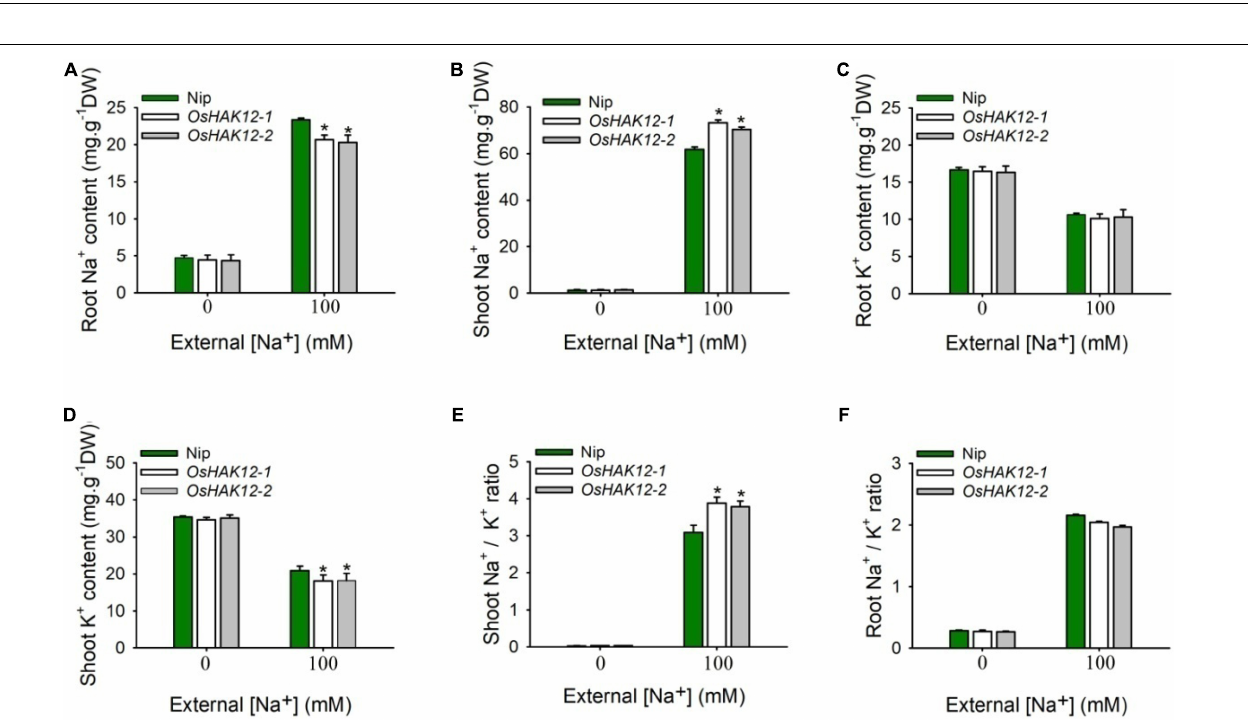
FIGURE 4 | Disruption of OsHAK12 affects Na + and K + ionic accumulation during salt stress. Na + and K + contents of the Nip and Oshak12 mutants ( Oshak12-1 , Oshak12-2 ) were measured by ICP-MS. Growth conditions were as described in Figure 1A . (A) Root Na + content of the Nip and Oshak12 mutants. Significant differences were found between the Nip and Oshak12 mutants ( n = 50 for each data point) (* P < 0.005 by Student’s t -test). (B) Shoot Na + content of the Nip and Oshak12 mutants. Significant differences were found between the Nip and Oshak12 mutants ( n = 50 for each data point) (* P < 0.005 by Student’s t -test). (C) Root K + content of the Nip and Oshak12 mutants. No significant differences were found between the Nip and Oshak12 mutants ( n = 50 for each data point) ( P > 0.05 by Student’s t -test). (D) Shoot K + content of the Nip and Oshak12 mutants. Significant differences were found between the Nip and Oshak12 mutants plants ( n = 50 for each data point) (* P < 0.01 by Student’s t -test). (E) Shoot Na + / K + ratio in Nip and Oshak12 mutants. The Nip and Oshak12 mutants showed significant differences (* P < 0.01 by Student’s t -test). (F) Root Na + / K + ratio in Nip and Oshak12 mutants. The Nip and Oshak12 mutants showed no significant differences ( P > 0.05 by Student’s t -test). The experiment was repeated three times with similar results. Data are means of three replicates of one experiment. Asterisks represent significant differences. Error bars represent ± SD.